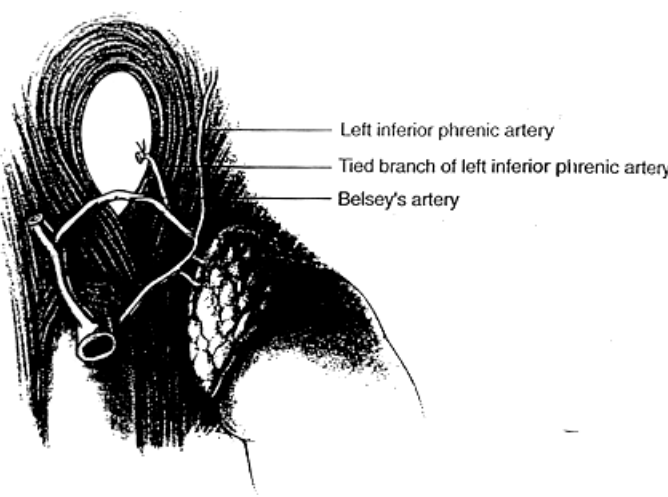
FIGURE 1 . Superior blood supply to the adrenal showing Belsey's artery which lies quite close to the esophageal hiatus and runs in close contact to the phrenic vein. (From: Skinner DB: Atlas of Esophageal Surgery. Churchill Livingston: NY, 1991, pp. 119).